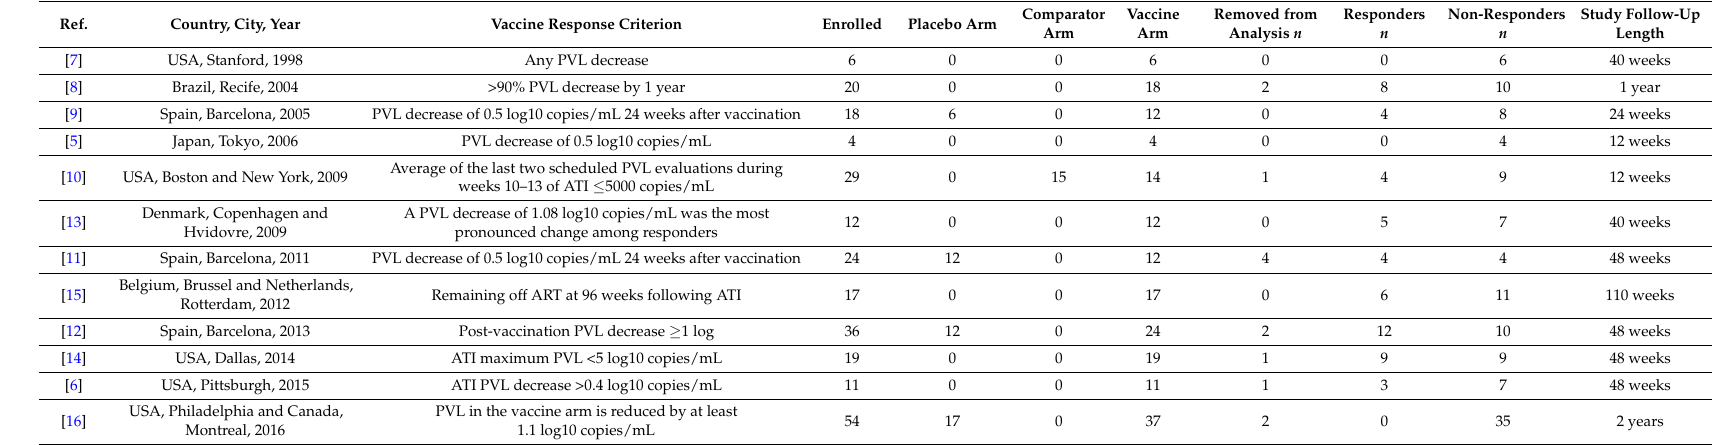
Table 2. Vaccine response criteria of the 12 studies and sample size breakdown for the estimation of global treatment success rate from dendritic cell-based experimental anti-HIV